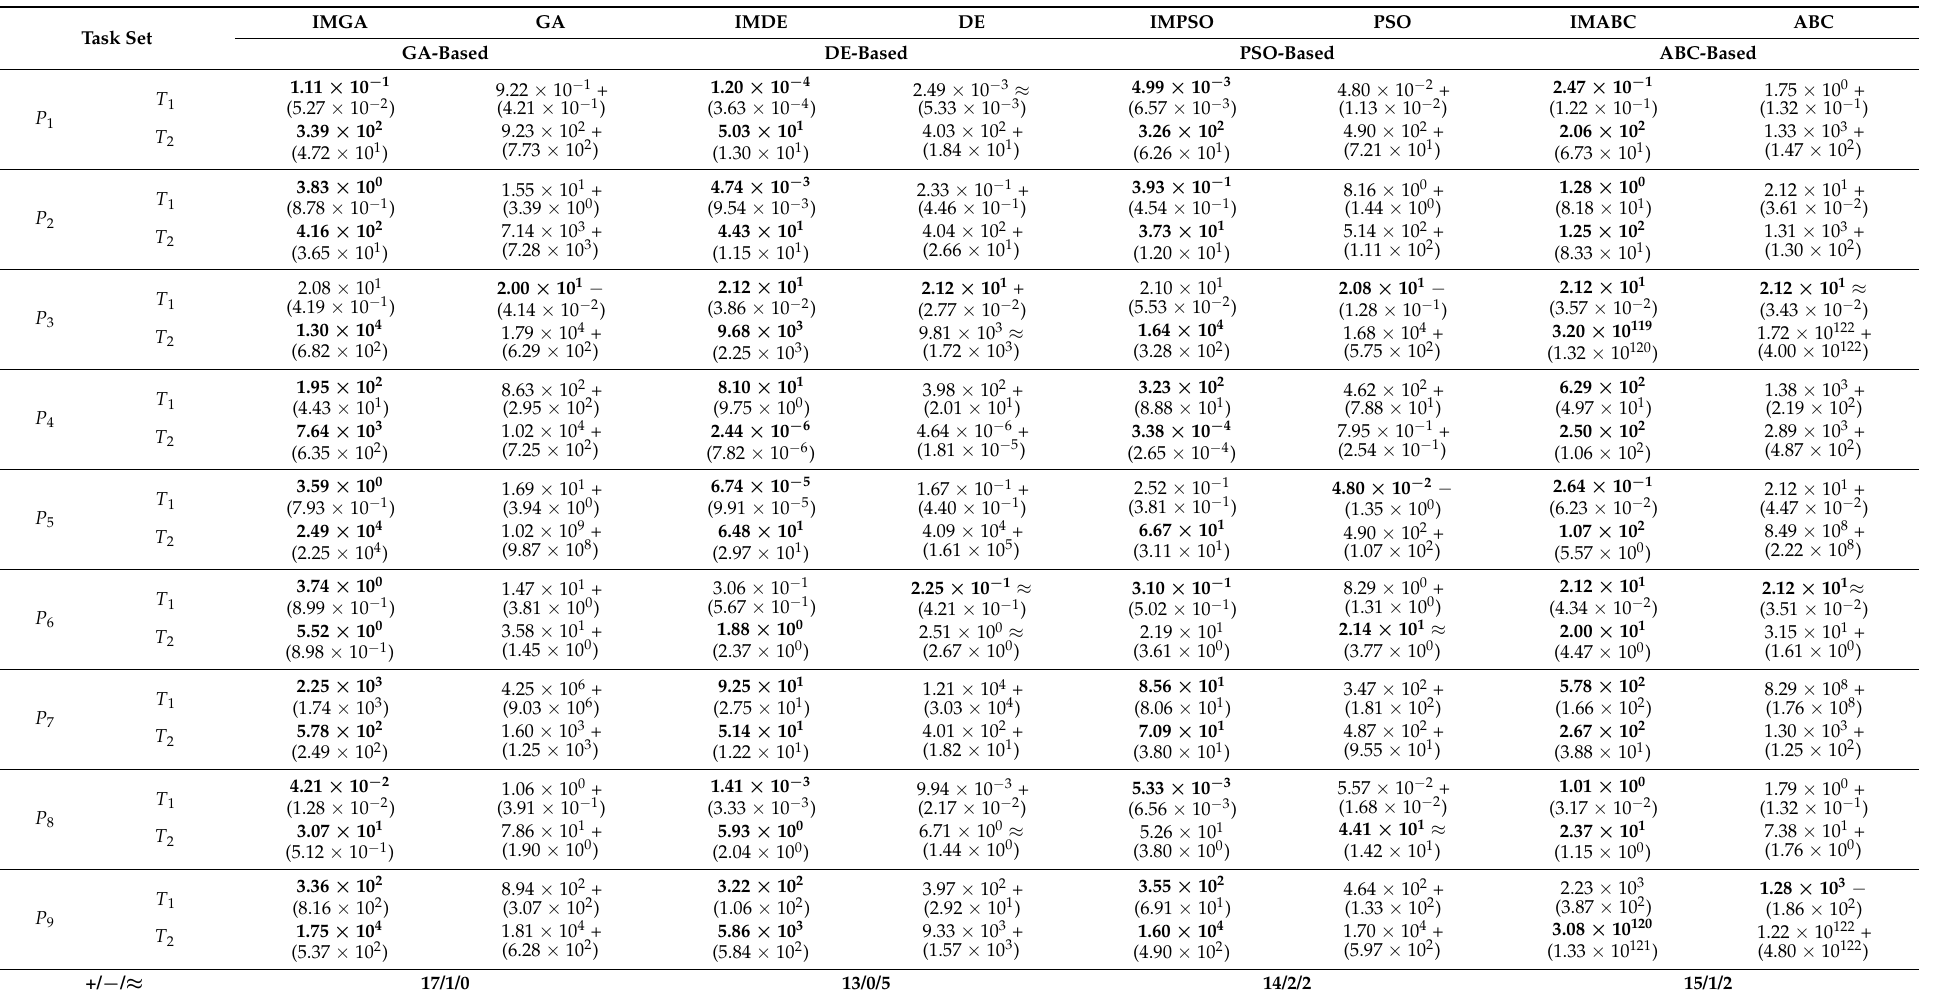
Table 6. The mean and standard deviation (in brackets) of the best achieved fitness values in test Suite